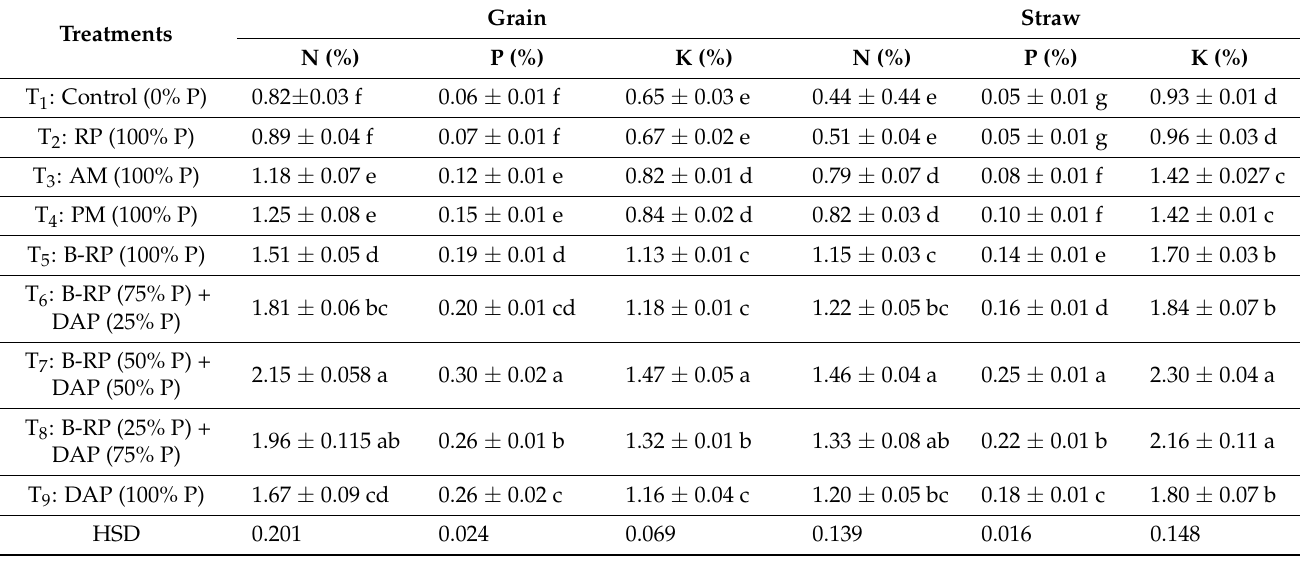
Table 2. Effect of different combinations of B-RP and DAP on chemical parameters of wheat. Grain Treatments